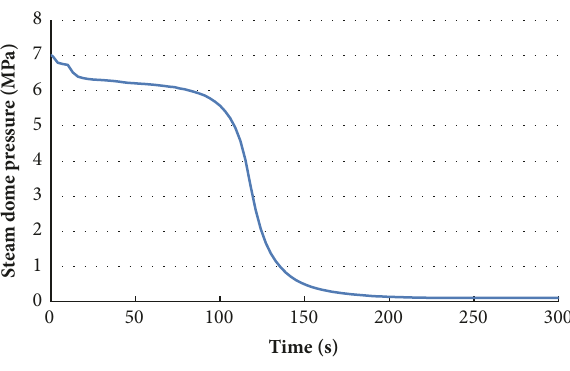
Figure 6: Steam dome pressure.